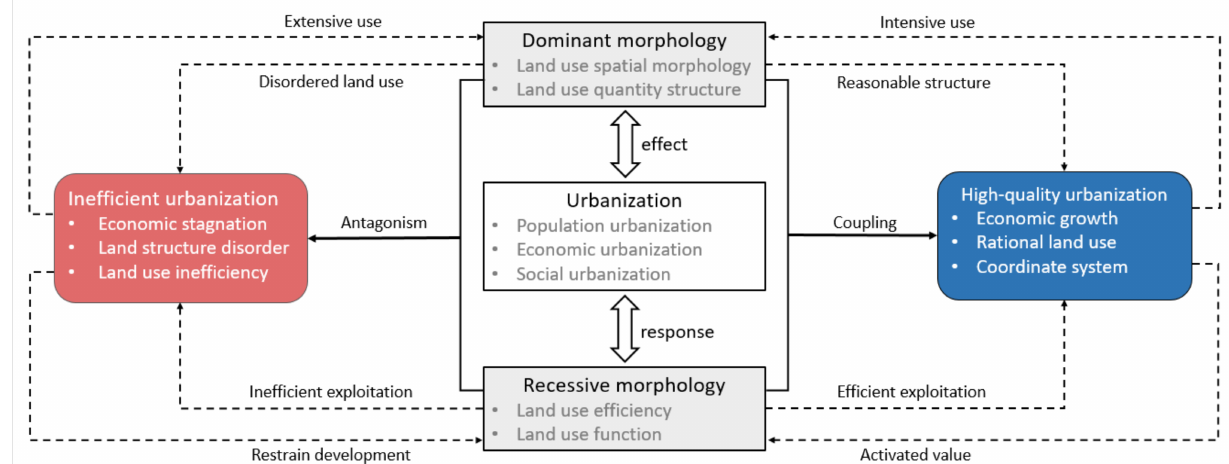
Figure 1. Analytical framework of interactive relationship between urbanization and land-use